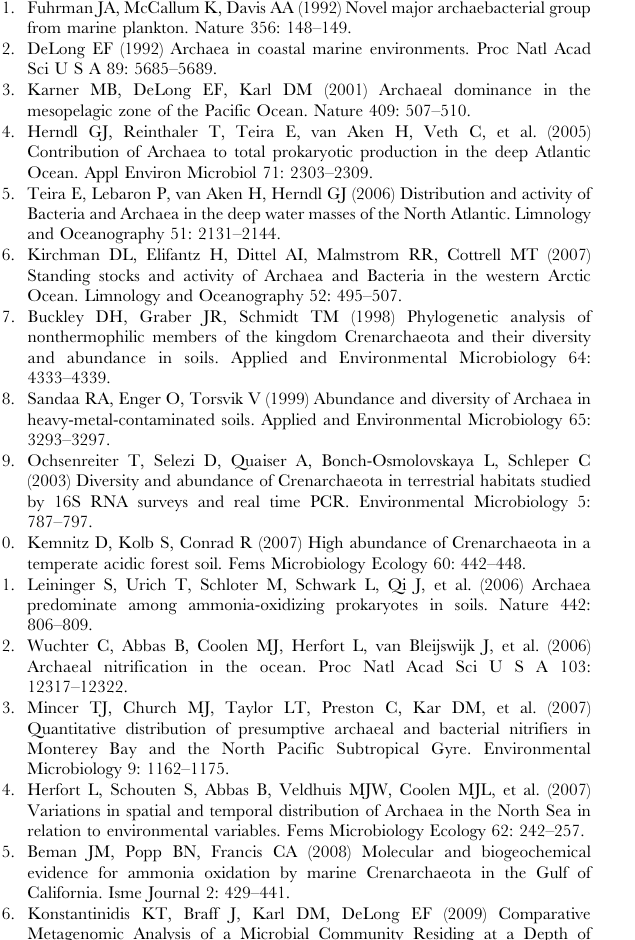
Figure S3 Synteny plots relating N. limnia to the N. maritimus and C. symbiosum A genomes.